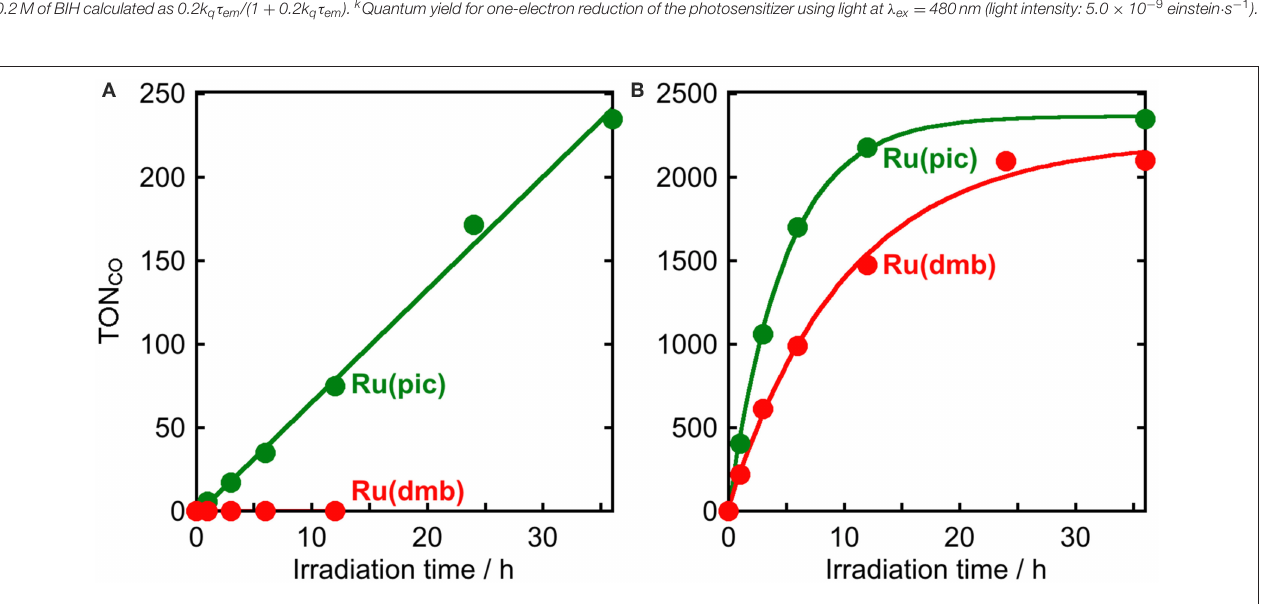
FIGURE 6 | Photocatalytic production of CO as a function of irradiation time using Ru(pic) ( (5:1 v/v, 2mL) solutions containing Ru(II) photosensitizer (50 µ M), Re (50 µ M), and BIH (0.2M) were irradiated at (A) λ ex > 620nm or (B) λ ex > 500nm.